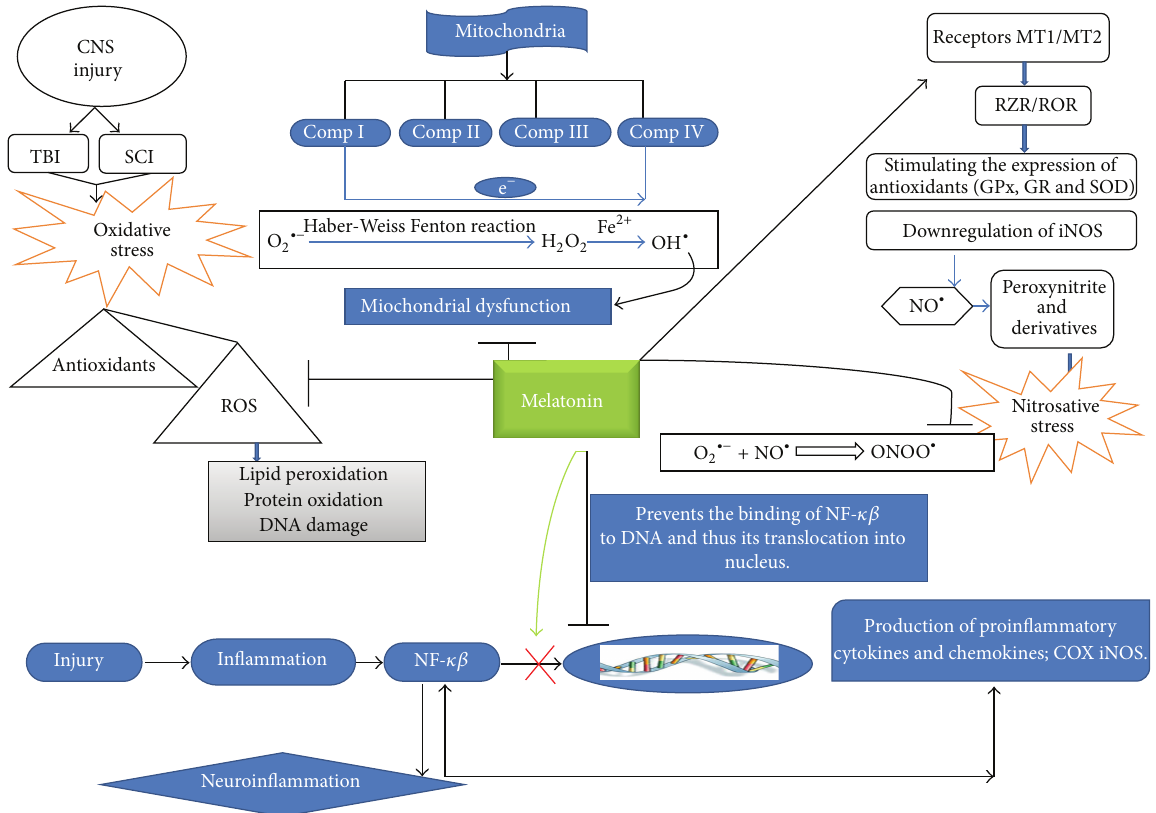
Figure 3: Role of melatonin in several stress conditions. CNS injury includes TBI and SCI which leads to oxidative stress which promotes ROS at a very high level compared to that of antioxidants and plays an important role in the pathogenesis of disease. ROS reacts with PUFA of lipid membranes which results in lipid peroxidation. ROS can also damage DNA and protein which leads to protein oxidation and DNA damage. Melatonin acts as a radical scavenger as it reduces the level of ROS. Fenton reaction leads to the production of hydroxyl radical OH associated with mitochondrial complexes and melatonin has metal binding capacity which may form chelating compound and reduce OH generation. Melatonin is a natural ligand for a nuclear retinoid related orphan nuclear hormone receptor superfamily RZR/ROR. Melatonin involves the regulation of expression antioxidant enzymes like GPx, GR, and SOD by involving MT1/MT2 and ROR receptors. Melatonin acts as an antinitrosative agent by reducing ONOO. CNS injury triggers cerebral inflammation which involves NF- 𝜅𝛽 which is a key player in secondary injury. Here melatonin acts as an antineuroinflammatory agent and inhibits the activation of NF- 𝜅𝛽 and its binding to